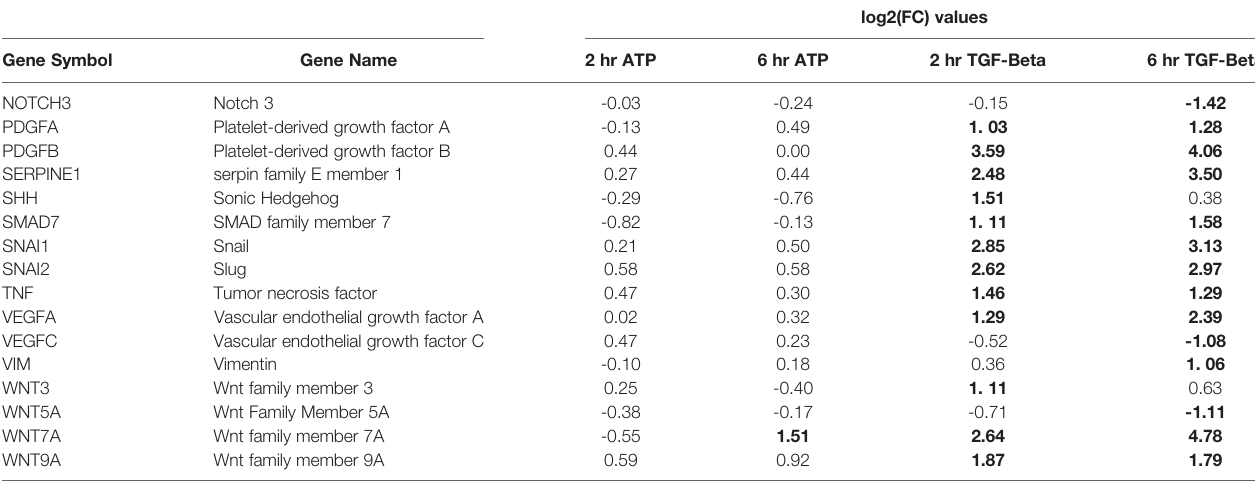
TABLE 3 | EMT genes signi fi cantly changed by TGF- b treatment only (but may not be changed at both time points).